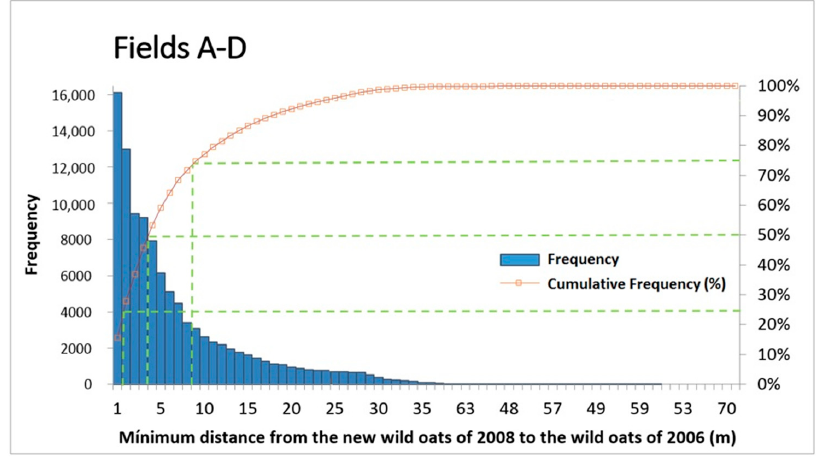
Figure 4. Average spreading distance of the four studied fields by a cumulative frequency histogram. Independent of this different behavior, the percentage of wild oat-infested treated area of the treatments proposed (WOTA) was similar in all of the simulations and fields analyzed with values higher than 99%. In addition to this high coincidence of WOTA in all studied fields, the maximum difference between the treated area (TA) and the simulated infested area (WOA) did not exceed 1.5% levels lower than 25% in the treatment unit area were minimal.